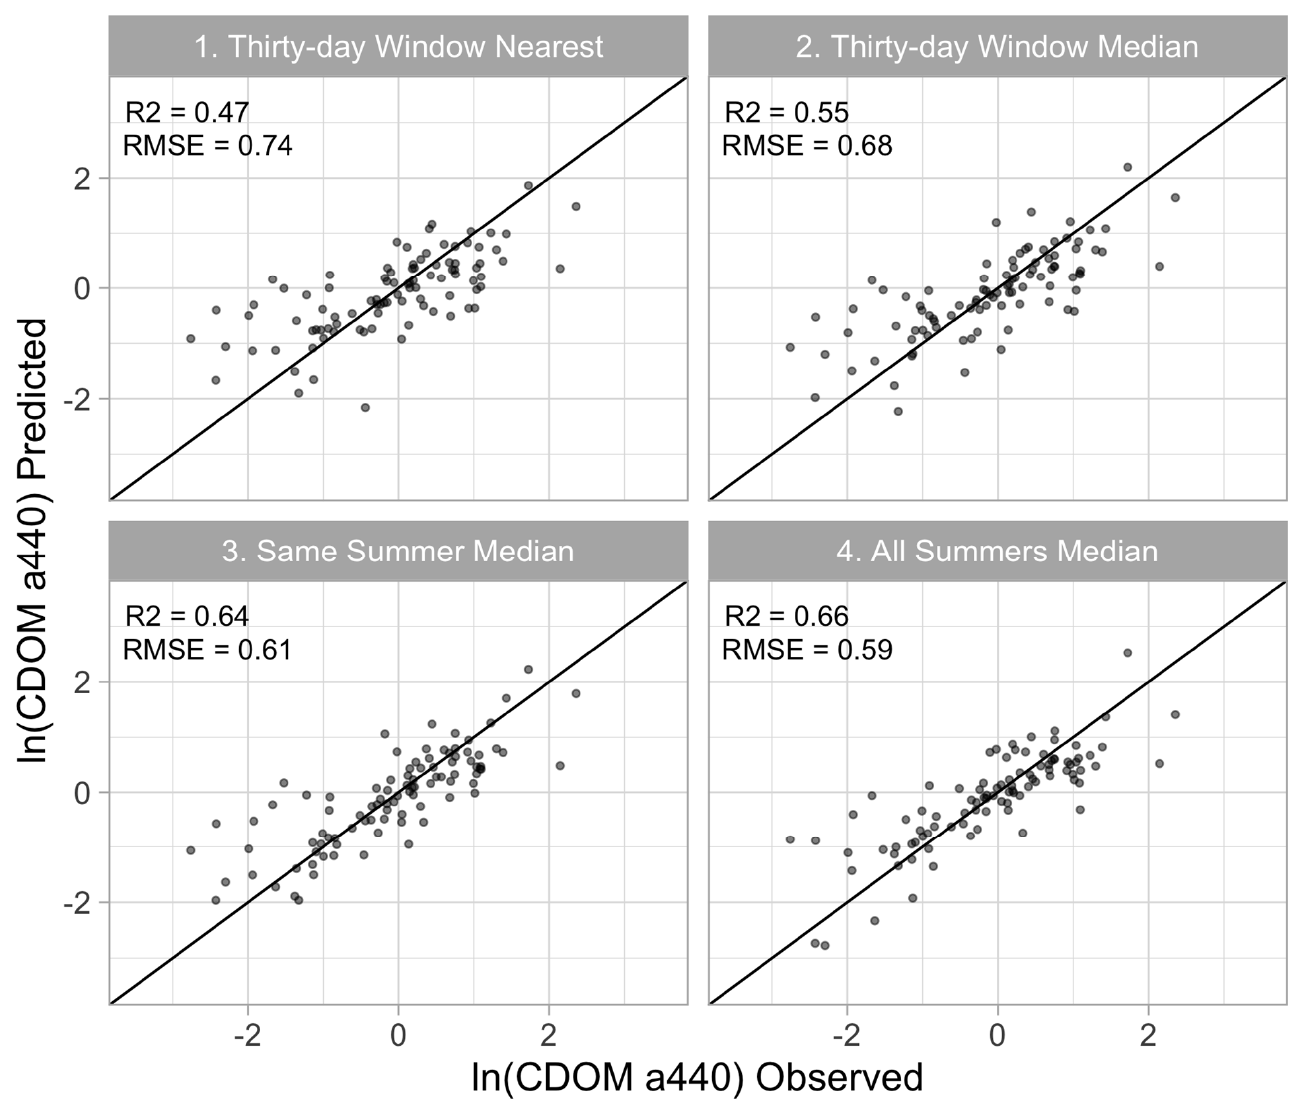
Figure 5. Predicted versus actual plots for CDOM( a 440 ) regression in the validation lakes ( n = 96). Regressions were fit using satellite data from different time windows: ( 1 ) nearest image within 30 days; ( 2 ) median of any clear images in a 30-day window; ( 3 ) clear images from same summer as field sample; ( 4 ) all clear summer images from all years of the Landsat 8 record (2013–2019). Diagonal lines represent the 1:1 line.